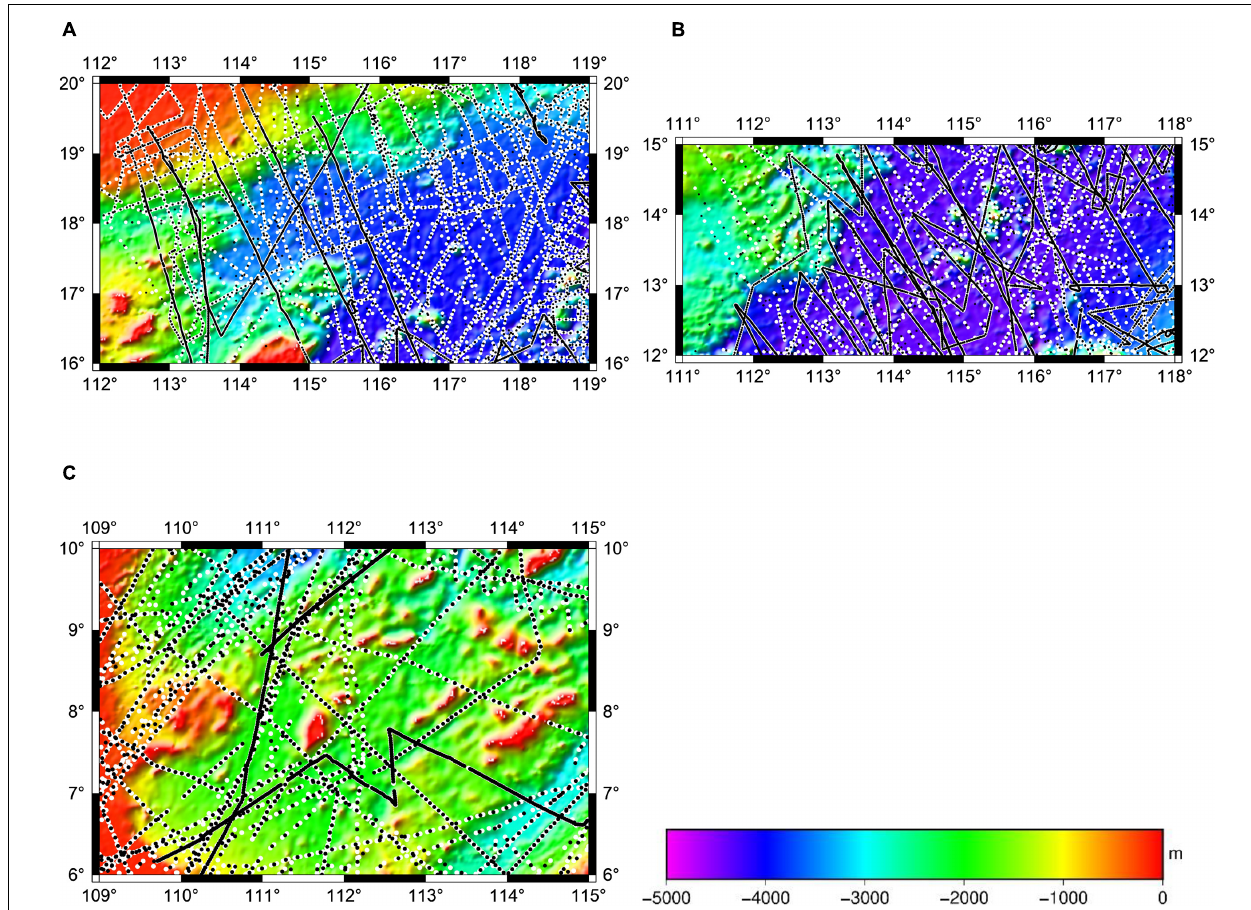
FIGURE 4 | Distribution of ship-borne bathymetry tracks for the test areas of the SCS. (A) Ship-borne bathymetry tracks in test area A. (B) Ship-borne bathymetry tracks in test area B. (C) Ship-borne bathymetry tracks in test area C. By considering the similarity of tomograms, the density of ship track data in each of these regions is evaluated through digital image processing-based metrics. Control points are represented by black points, and check points are represented by white